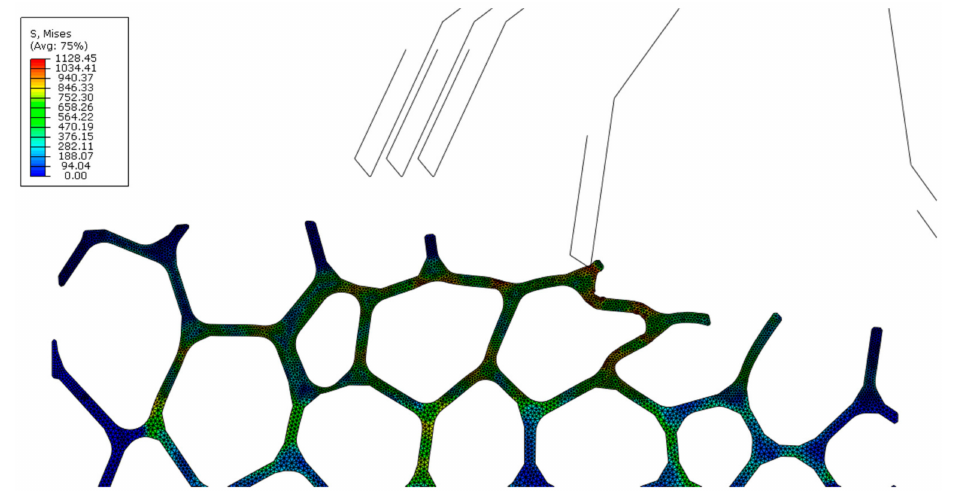
Figure 11. Stress distribution during down milling (von Mises in MPa, Model A, v c = 100 m / min, f z = 0.30 mm): during the 2nd sweep.